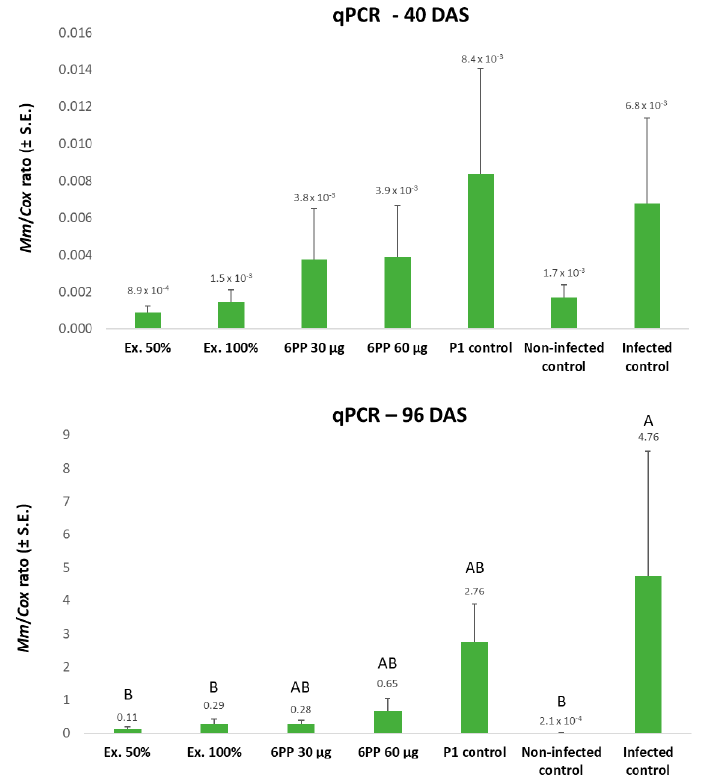
Figure 7. qPCR estimate of M. maydis DNA on days 40 and 96 of the net house experiment. The relative amount of M. maydis DNA ( Mm ) normalized to the cytochrome C oxidase (Cox) DNA was assessed in the plants’ first aboveground internode. The experiment’s treatments and controls are depicted in Figure 5. Error lines represent the standard error of an average of 7–10 repetitions (plants). If they exist, statistically significant differences ( p < 0.05) between treatments are specified by different letters (A–B).